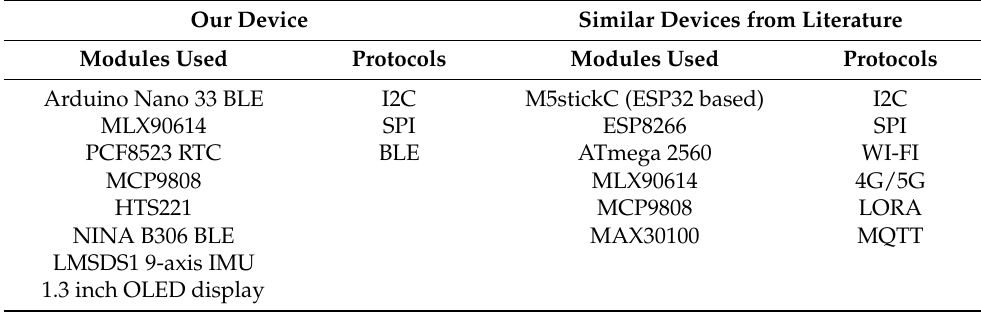
Table 1. Sensors and protocols in this project compared to pertinent literature. Our